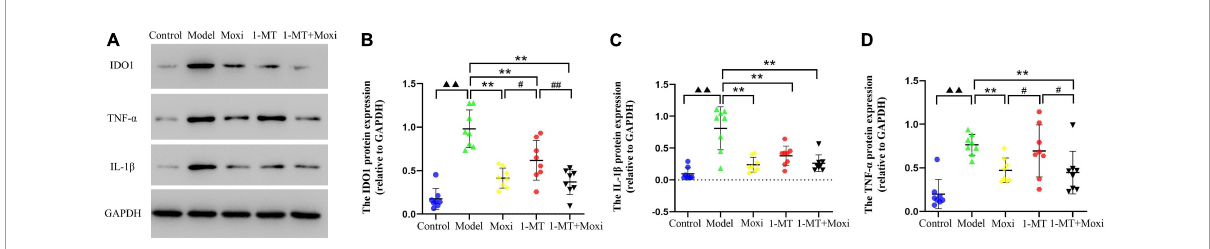
FIGURE9 Effects of moxibustion, 1-MT, or a combination of both on protein expression of IDO1, IL-1 β , and TNF- α in the hippocampus. (A) Western blot bands of IDO1, IL-1 β , and TNF- α protein expression, (B) IDO1 protein expression, (C) TNF- α protein expression, and (D) IL-1 β protein expression in the hippocampus of rats in each group. n = 8 per group. (cid:78)(cid:78) P < 0.01 vs. control group; ** P < 0.01 vs. model group; # P < 0.05, ## P < 0.01 vs. 1-MT